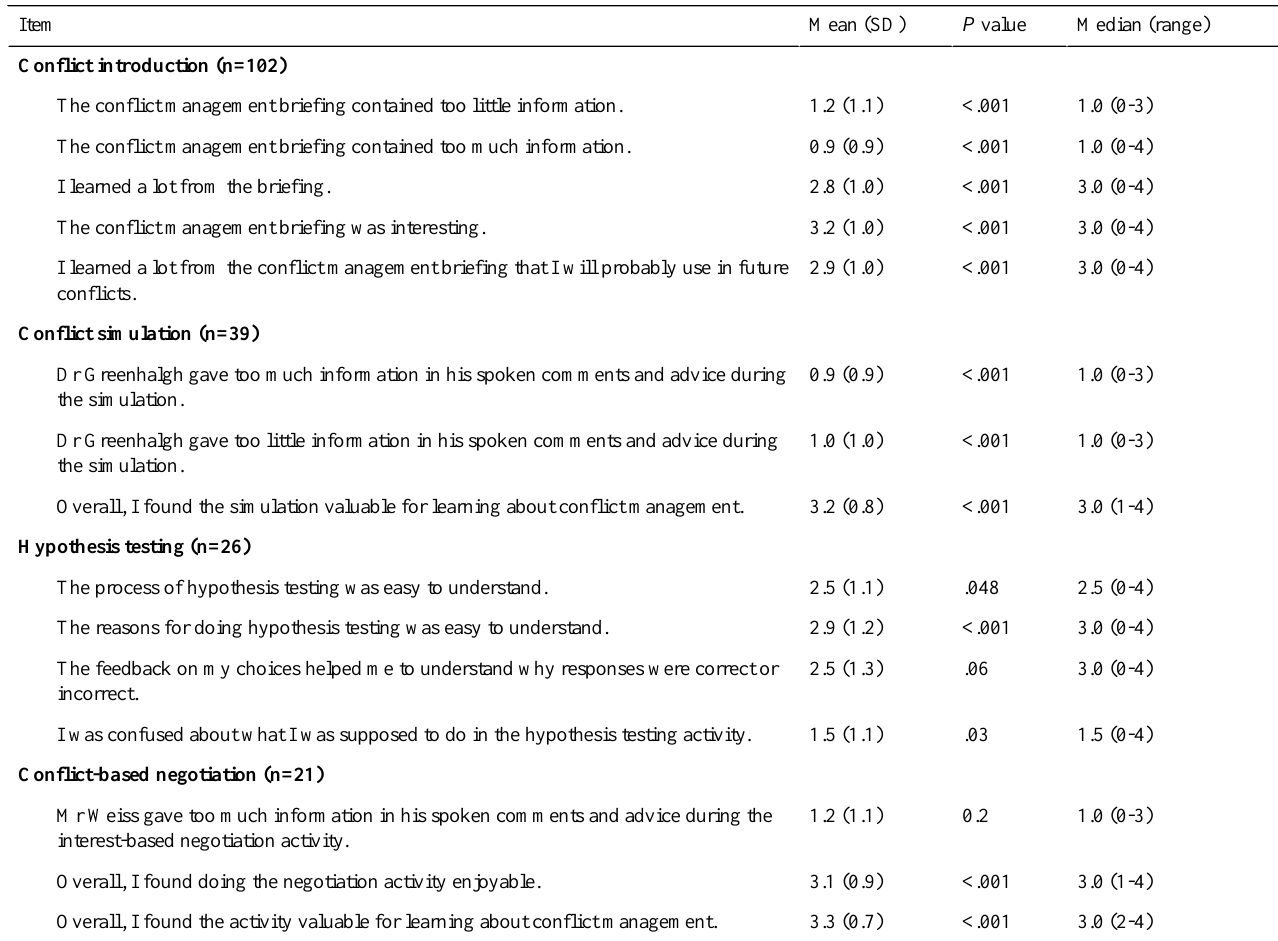
Table 1. The evaluation of conflict module scored on a 0-4 scale ranging from “strongly disagree” (0) to “strongly agree” (4). a